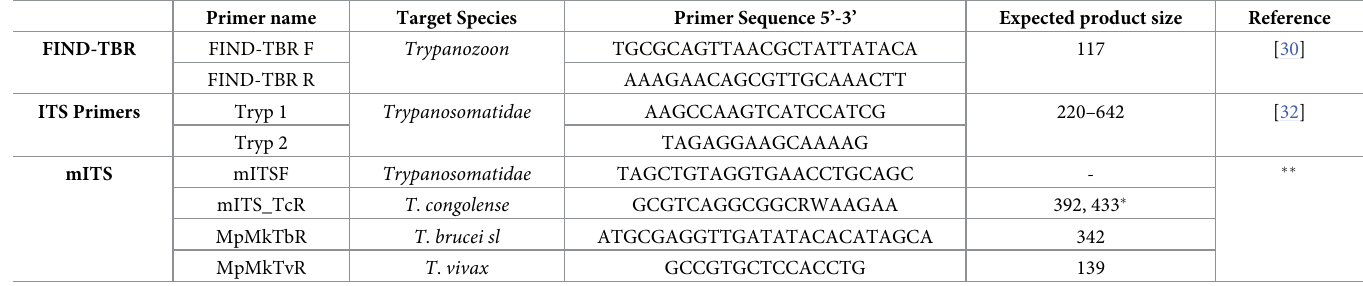
Table 2. Primers used for detection of T . brucei s.l.